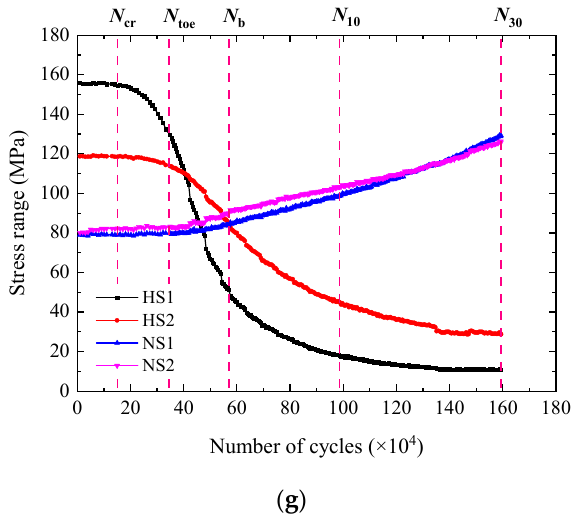
Figure 8. Variation of stress range with number of cycles for WS specimens. ( a ) W1-2. ( b ) W2-1. ( c ) W3-1. ( d ) W3-2. ( e ) W4-2. ( f ) W5-1. ( g ) W5-2.